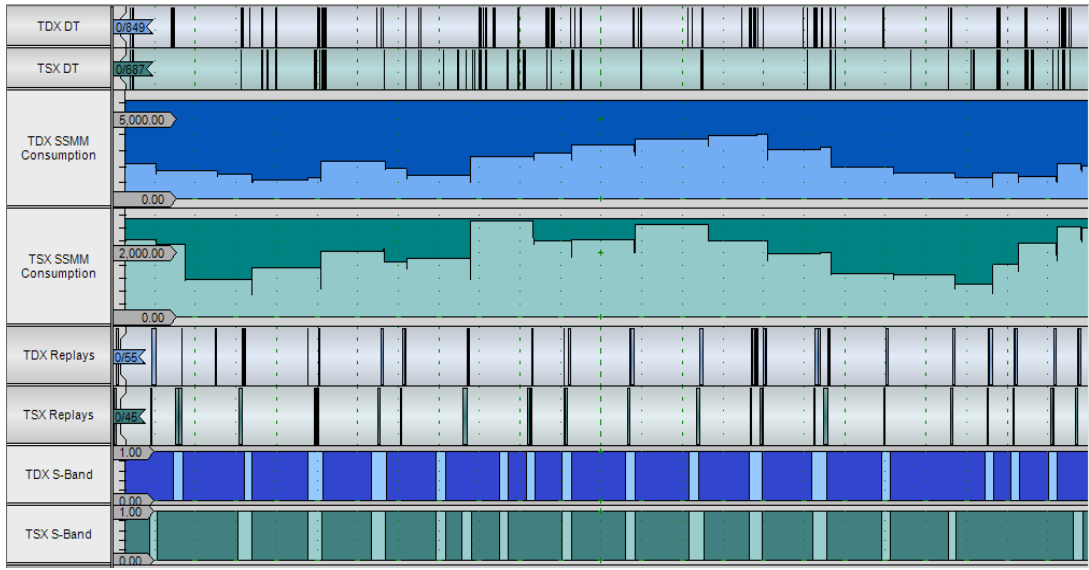
Figure 12 . Typical acquisition and downlink activities for TanDEM-X Satellite (TSX) and TanDEM-X Satellite (TDX) for about one day. DT rows: Data acquisition activities (number of tele-commands is given on the left hand side) SSMM rows: The on-board memory utilization (TDX’s memory has twice the size of TSX’s one, as indicated on the left hand side). Replay rows: The X-Band downlink contacts used (number of replays is given on the left hand side). S-Band rows: TT&C contacts (indicated by light color).